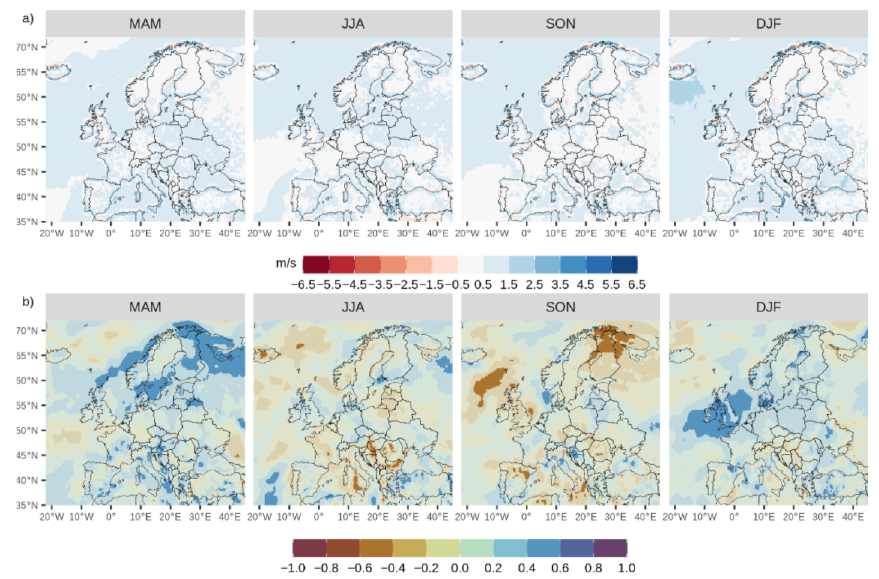
Figure 6. Spatial distribution of ( a ) ME and ( b ) CORR for unadjusted ECMWF SEAS5 ensemble forecasts of 10-m wind speed (one-month lead time) over Europe with respect to ERA5 reanalysis over 1993–2016. Significant correlation ( p -value < 0.05) is reported by unshaded